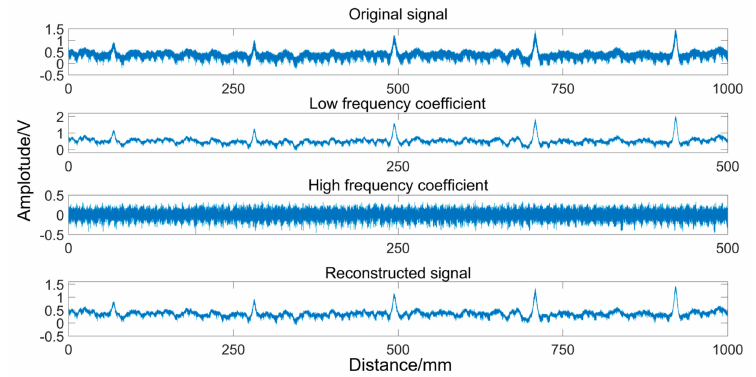
Figure 18. Denoising by